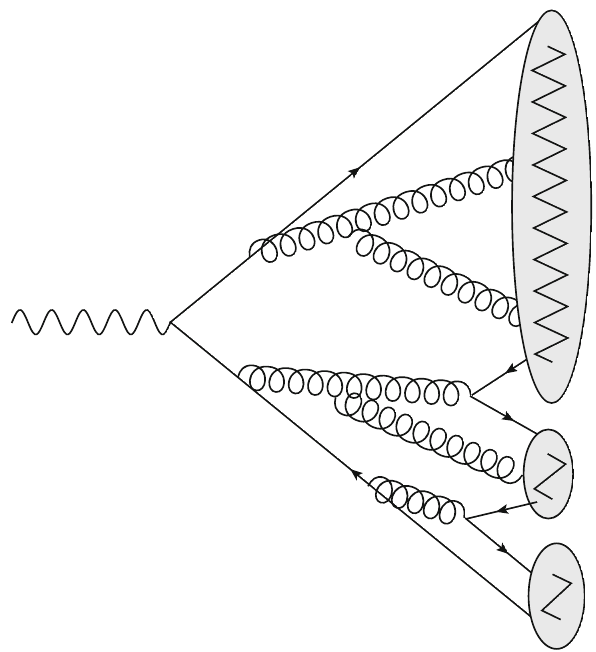
Fig. 6 Schematic topology of colour-singlets that can occur from per- turbative gluon and quark shower splitting, before the gluons undergo non-perturbative splitting